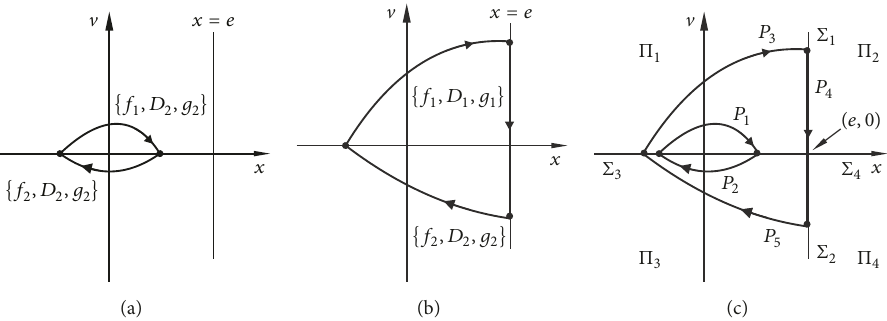
Figure 2: Representative trajectories and segments of (a) the nonimpacting period-1 orbit, (b) the period-1 orbit with one impact per period, and (c) the local